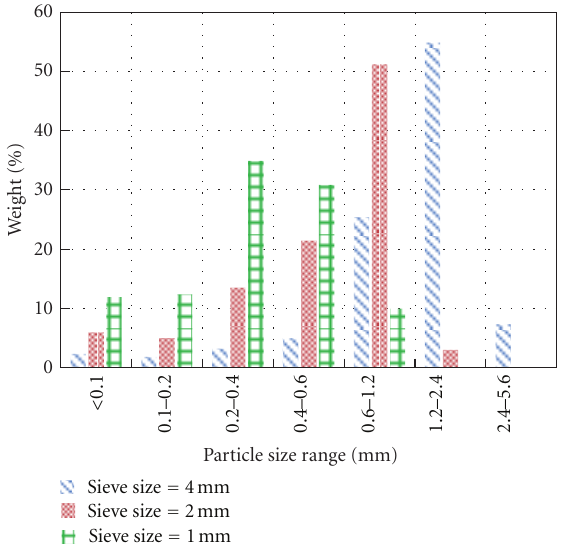
Figure 18: Particle size